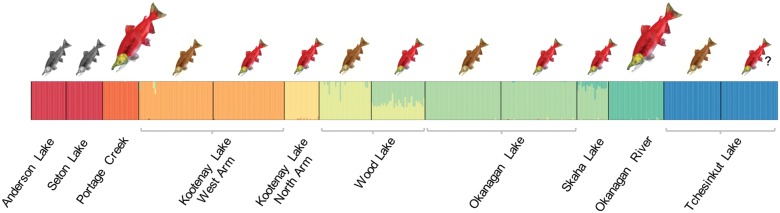
—FASTSTRUCTURE (Raj et al. 2014) plot based on genotypic data at 6,234 putatively neutral SNPs showing the proportion of cluster membership at K = 8. Vertical bars indicate individuals, colors represent proportion of cluster membership. Size and color of Oncorhynchus nerka images as in figure 1.